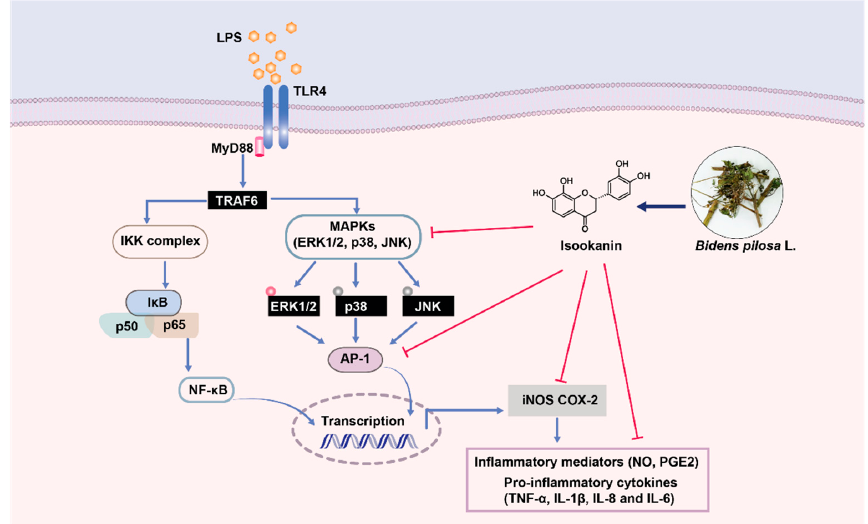
Figure 8. Anti-inflammatory mechanism of isookanin isolated from Bidens pilosa L. is associated with suppressing the TLR4-mediated AP-1 and MAPK signaling pathways induced by LPS. Supplementary Materials: Figure S1. HR-ESI MS/MS spectra of compound 1 (A. protocatechuic acid) and compound 2 (B. isookanin). Figure S2. 1D NMR spectra of isookanin (2) (A) 1 H NMR spectrum and (B) 13 C NMR spectrum. Inset in (A) shows the chemical structure of isookanin. Figure